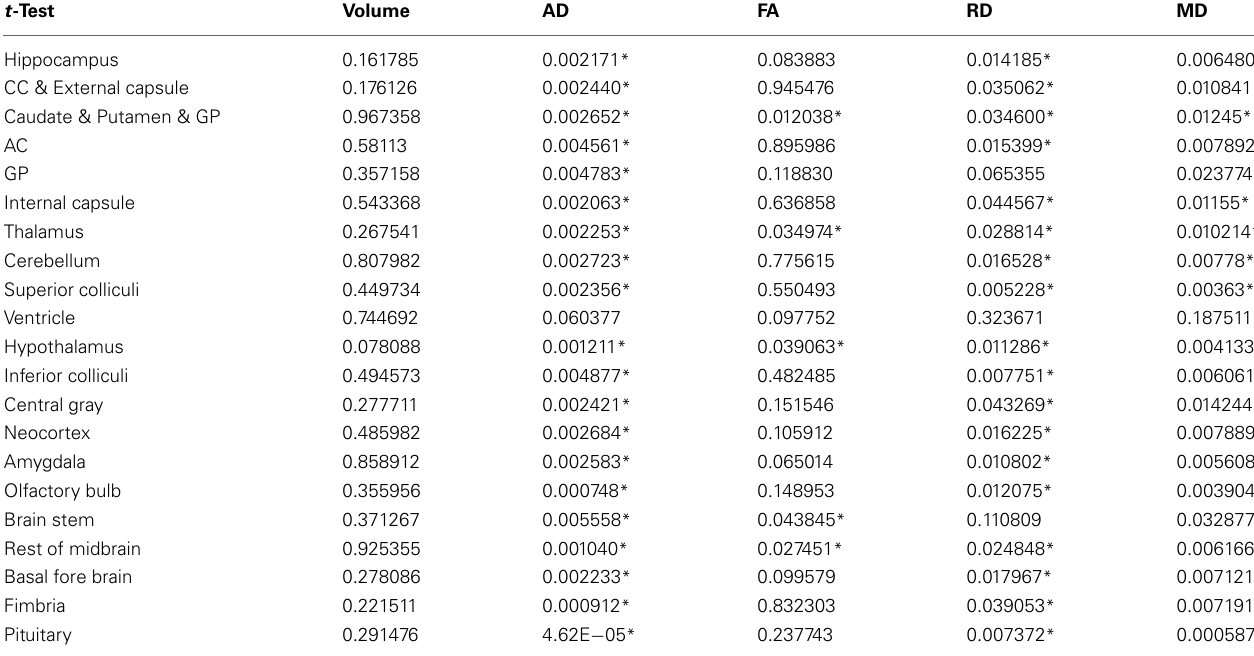
Table 2 | t -Test of the regional differences between the two